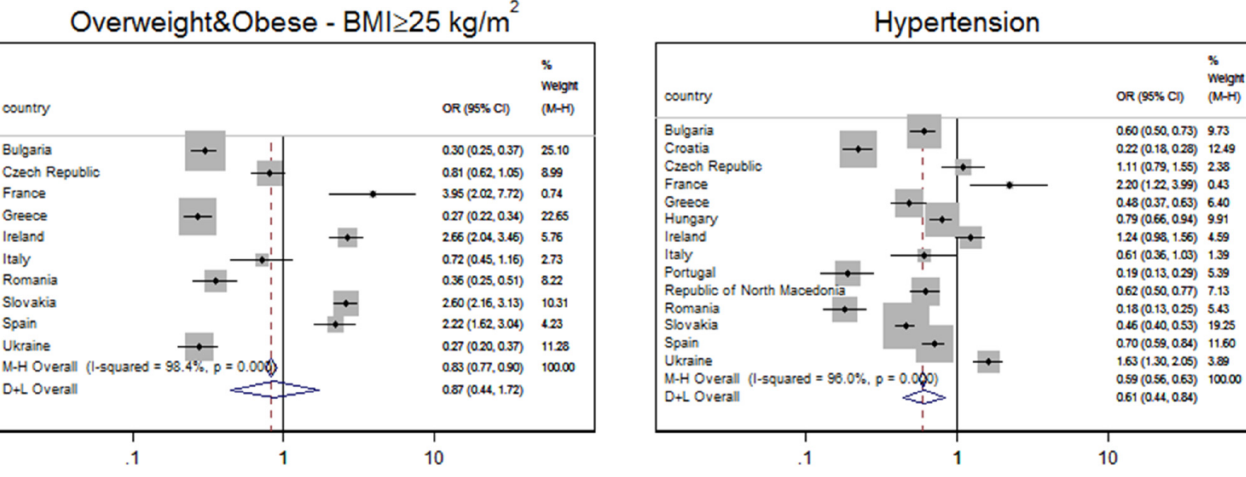
Figure 2. Forest plot showing an association between the Roma ethnicity and lower odds ratio (OR < 1) for the prevalence of BMI ≥ 25 kg/m 2 and hypertension, compared to the majority population. Results are stratified by